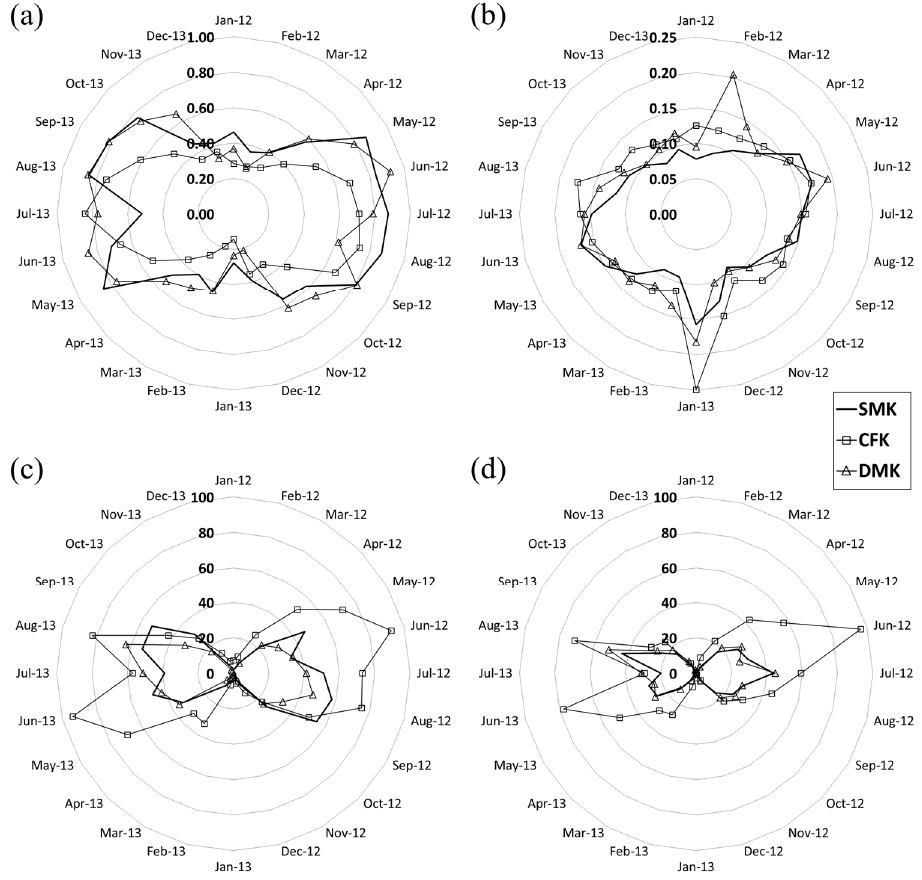
Figure 8. Comparison of the monthly data for SMK, CFK, and DMK: ( a ) NDVI; ( b ) albedo; ( c ) flux tower ET; and ( d ) SEBAL ET.